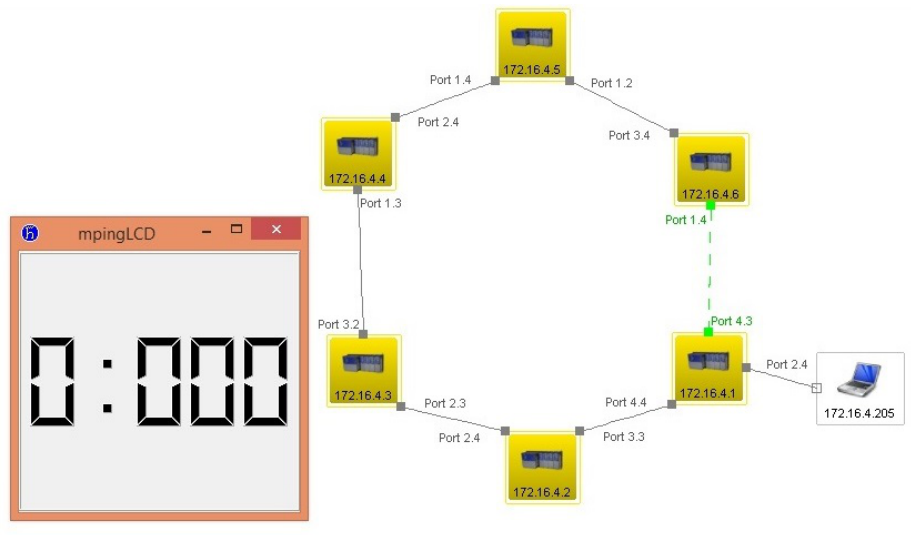
Figure 18. MRP ring network with no cable failure.